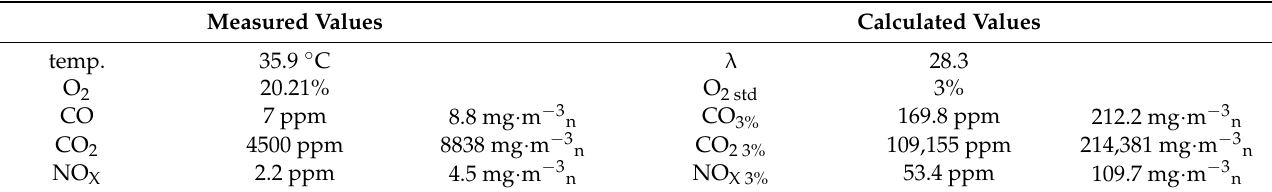
Table 15. Composition of drying air over a gas burner for the S428.CS dryer. Measured Values Calculated Values